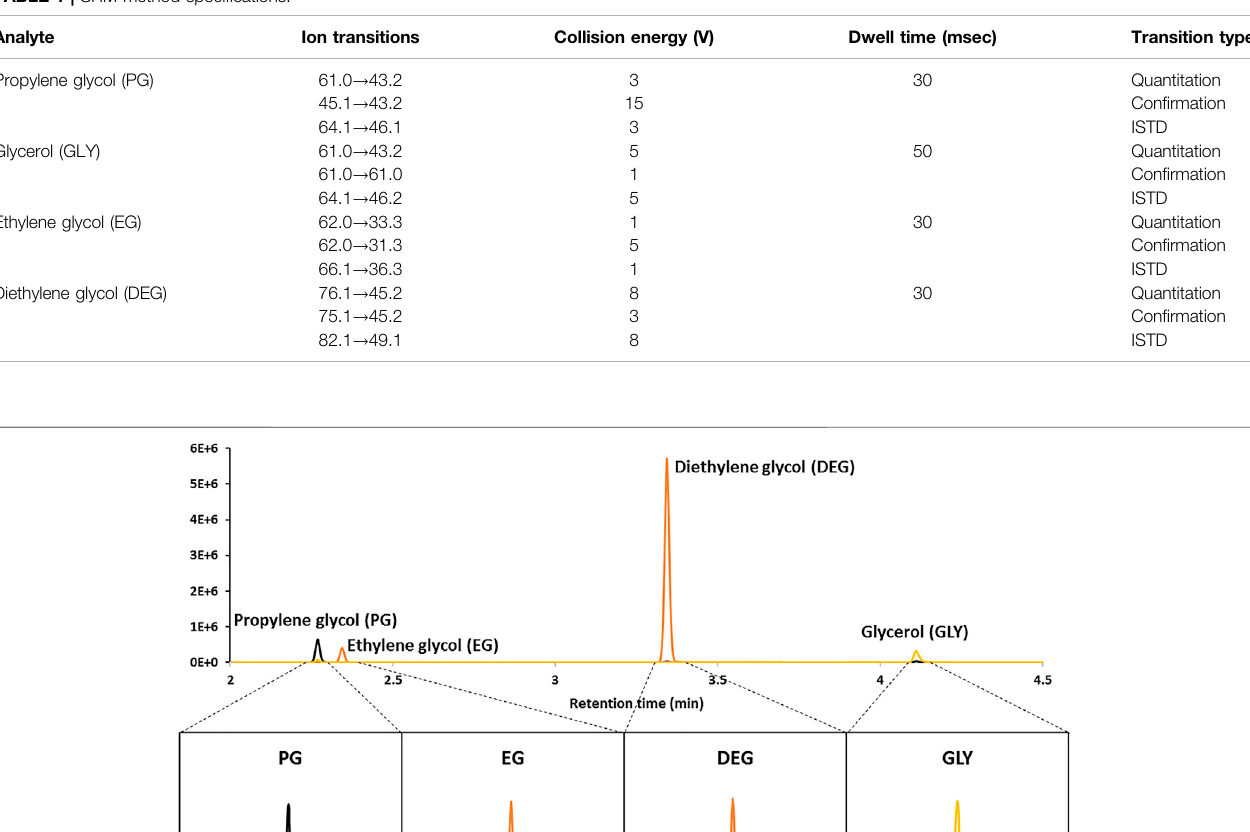
Frontiers in Chemistry |